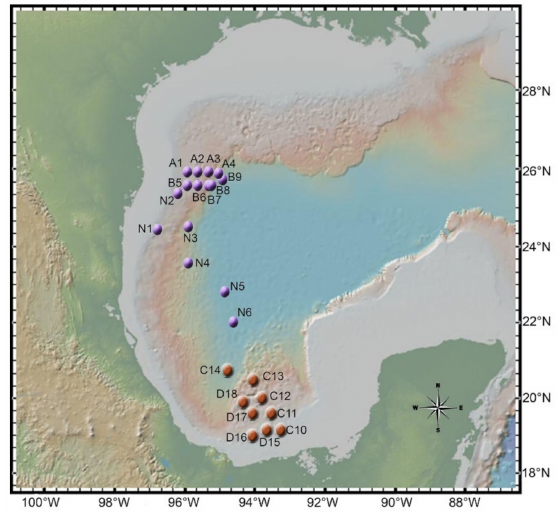
Figure 1. Localization of twenty-four sampled stations in the Gulf of Mexico, nine in Coatzacoalcos, also known as the Salina basin (orange dots), and fifteen in the Perdido fold belt region (purple